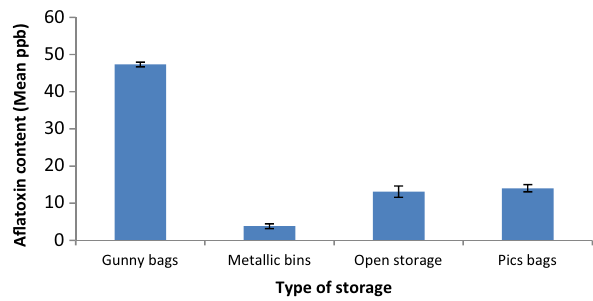
Figure 2: A fl atoxin levels of maize stored in di ff erent types of storages.